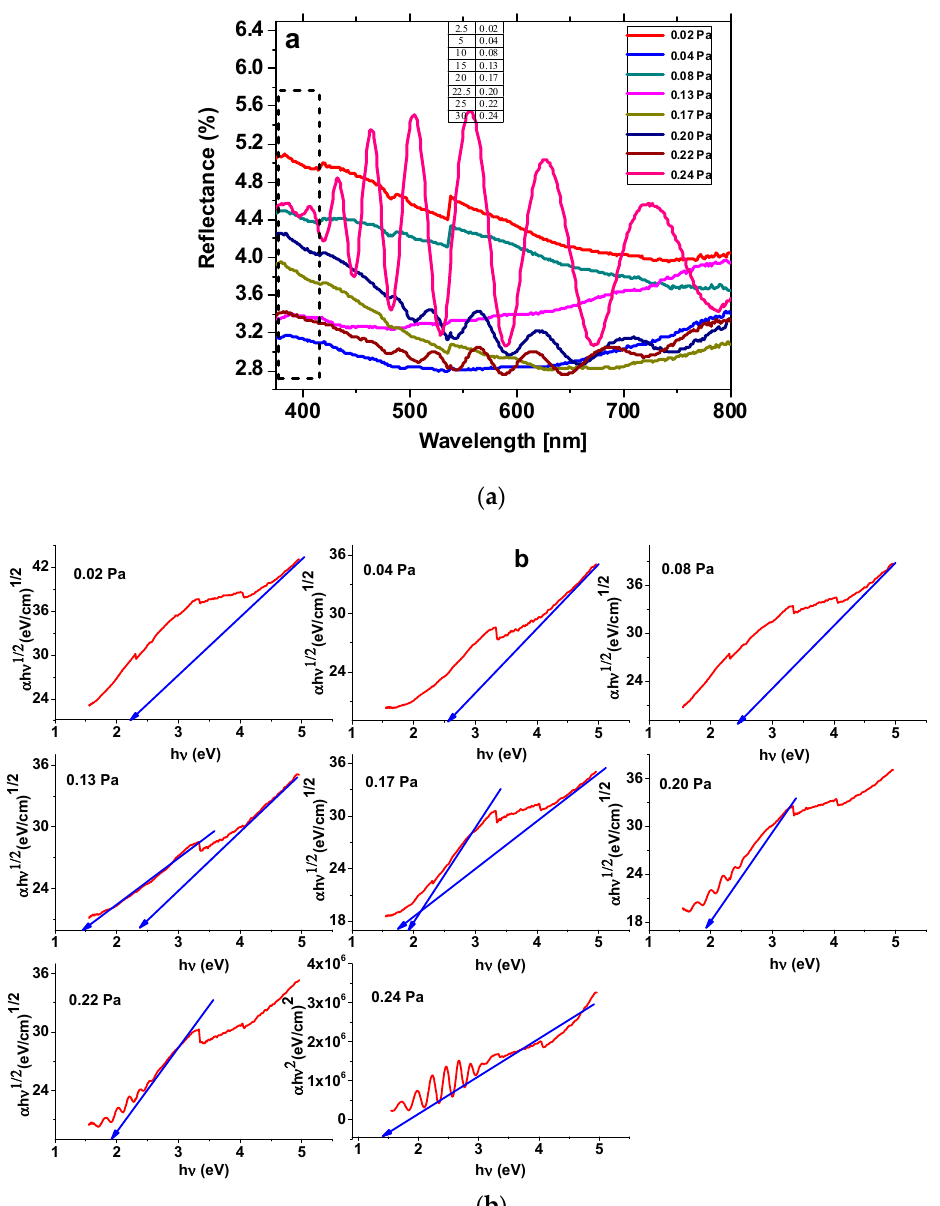
Figure 7. ( a ) UV-Vis spectra; ( b ) Tauc plots of the films.